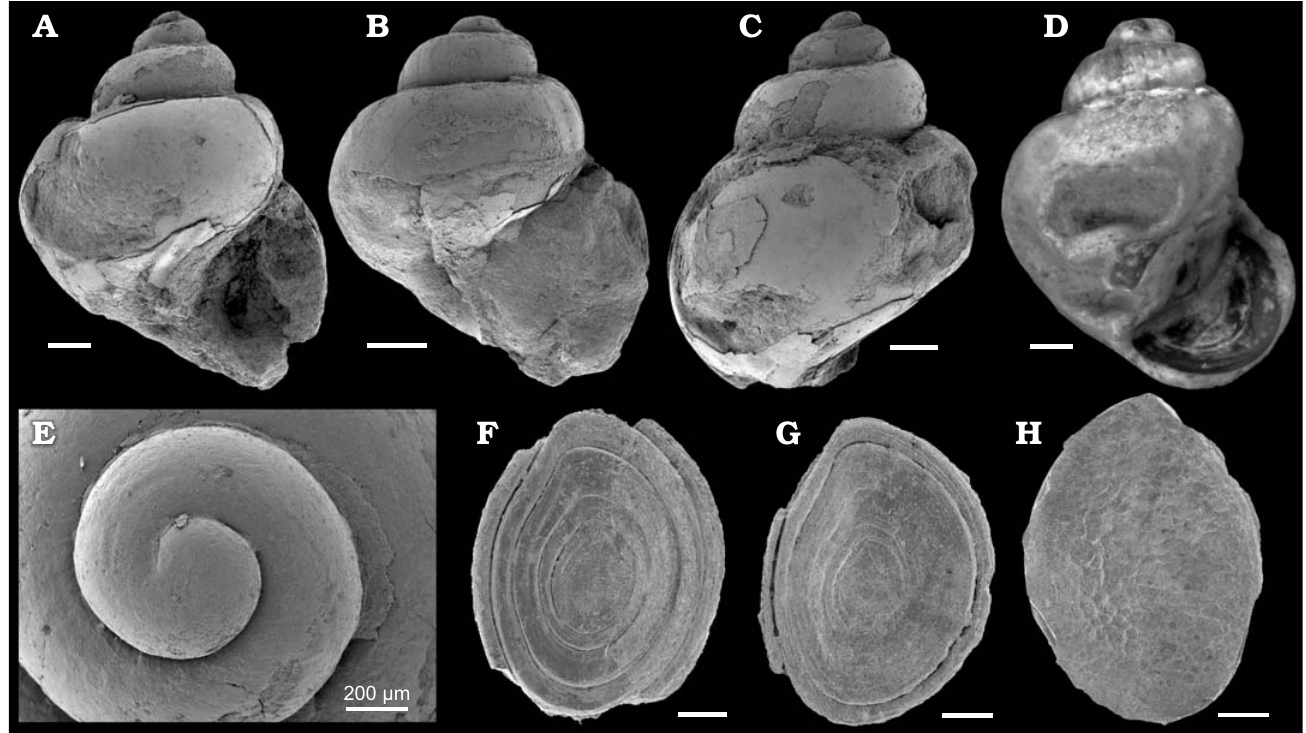
Fig. 3. Bithyniid gastropod Bithynia erzurumensis sp. nov. from the upper Oligocene–lower Miocene Susuz Formation, Kömürlü, Turkey. A . NHMW 2018/0019/0006, holotype in apertural view. B . NHMW 2018/0019/0007, paratype in apertural view. C . NHMW 2018/0019/0008, paratype in dorsal view. D . NHMW 2018/0019/0008, paratype in apertural view showing in situ operculum. E . NHMW 2018/0019/0010, paratype in apical view. F . NHMW 2018/0019/0012, outer surface of operculum. G . NHMW 2018/0019/0013, outer surface of operculum. H . NHMW 2018/0019/0014, inner surface of operculum. Scale bars 0.5 mm, if not stated otherwise. incised suture. Maximum diameter of last whorl in mid- height; aperture markedly angulated with posterior tip be- low periphery of last whorl.